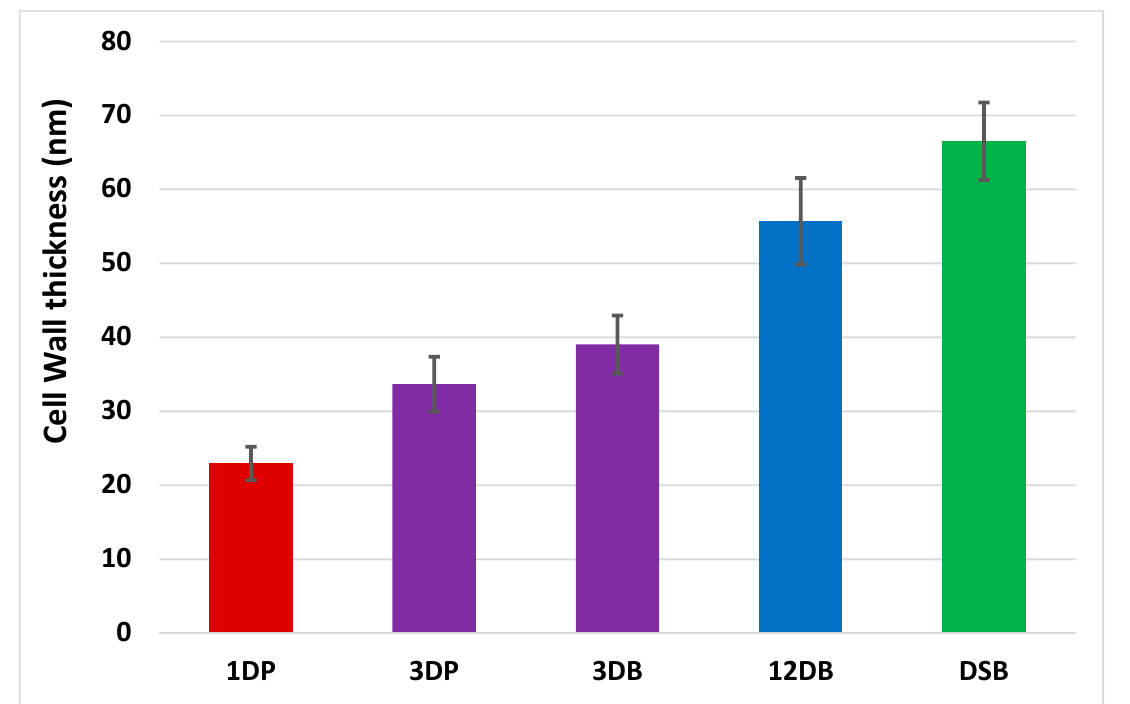
Figure 4. Cell wall thickness of S. aureus strain grown using different culture conditions. Columns of different colours pairwise comparisons were significantly different from each other ( p < 0.001 for all except DSB and 12-day hydrated biofilm p = 0.002). Only 3-day planktonic and 3-day biofilm cell walls (columns of the same colour) were not significantly different from each other.